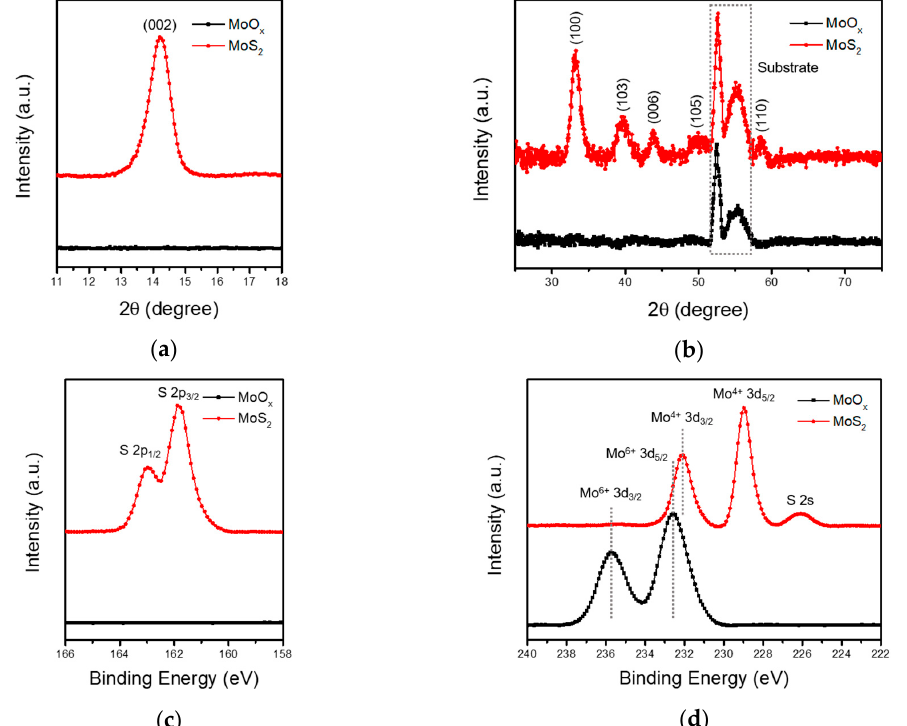
Figure 2. ( a ) (002)-Oriented XRD data, ( b ) (100), (103), (006), (105), and (110)-oriented XRD spectra. The gray-colored dash square indicates the substrate peaks. XPS spectra of Mo 3d ( c ) and S 2p ( d ) core levels of the MoO x and MoS 2 films.